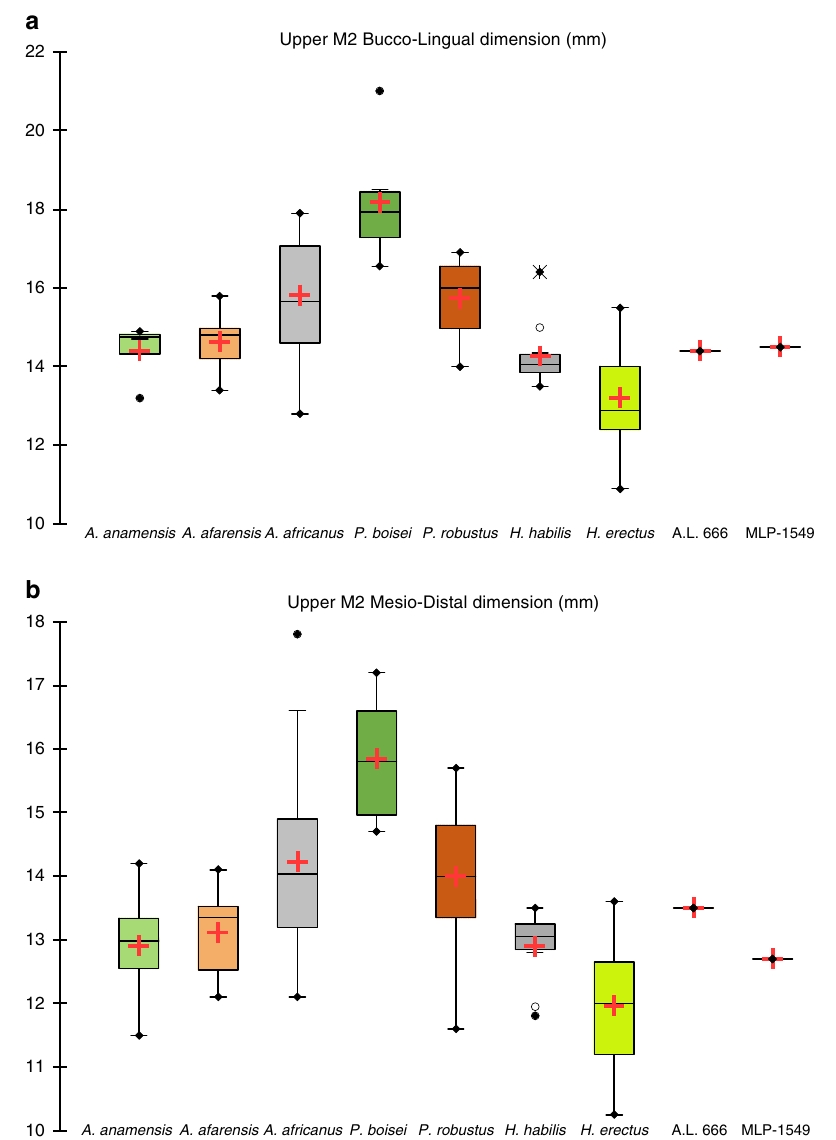
Fig. 4 Molar crown dimensions. Buccolingual and mesiodistal dimensions of MLP-1549 compared to values in Au. anamensis , Au. afarensis , Au. africanus , P. boisei , P. robustus , H. habilis , H. erectus & A.L. 666-1( Homo sp . from Hadar dated to 2.33 Ma). a upper second molar bucco-lingual dimensions in mm; b upper second molar mesio-distal dimensions in mm. Source data are provided as a Source Data fi